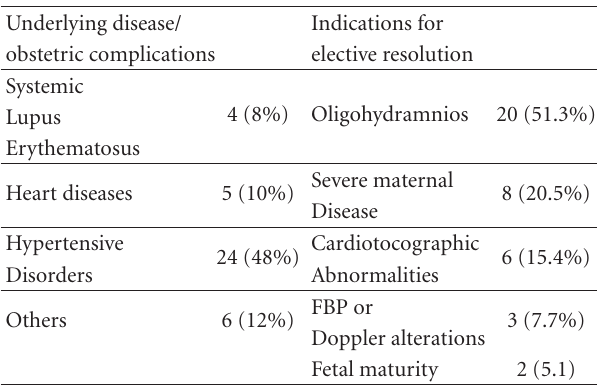
Table 1: Maternal characteristics and indications for elective preterm delivery in the IUGR group ( n = 50)